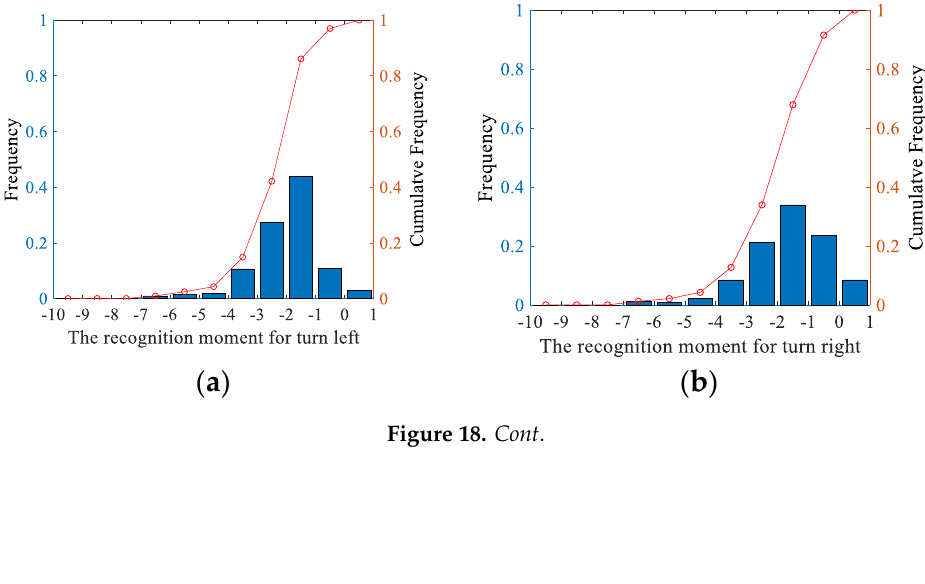
Figure 17. Performance of the proposed method at di ff erent times before the actual maneuver for the TR.